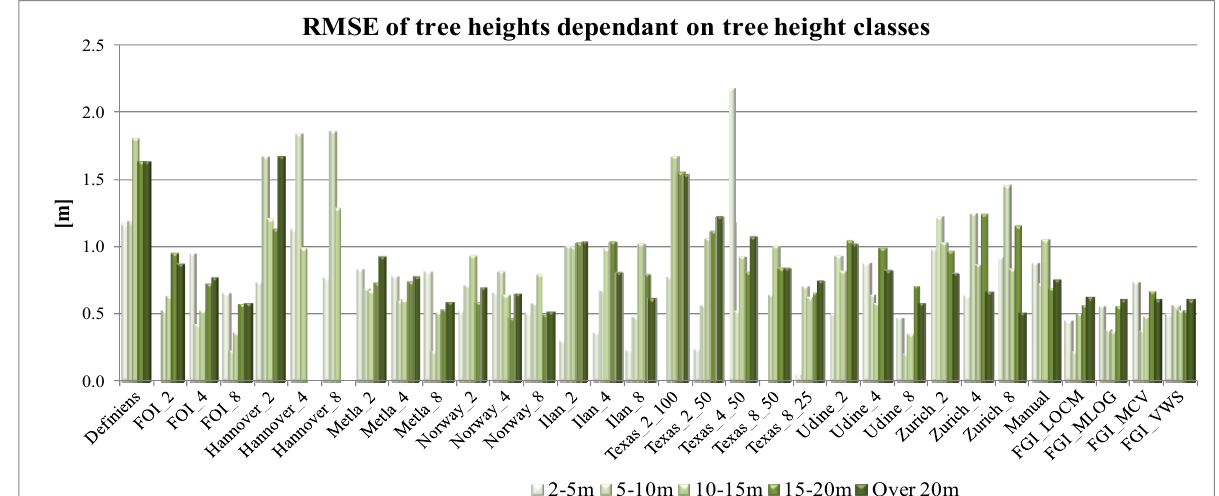
Figure 10. Accuracy of detected tree heights dependant on different height